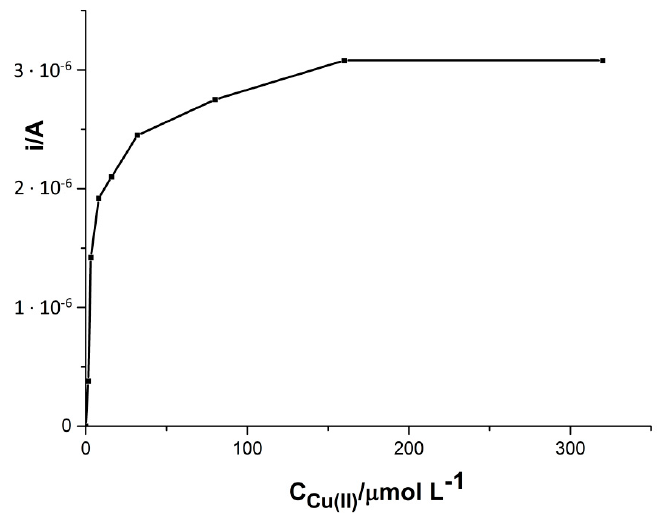
Figure 1. Influence of copper concentration on the Cd(II) signal. Concentration of Cd(II) 5 × 10 − 8 M. Accumulation potential − 0.7 V and accumulation time 60 s.